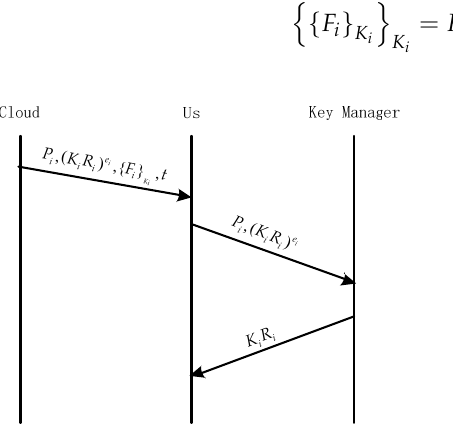
Figure 8. ADSS single-KM file download.